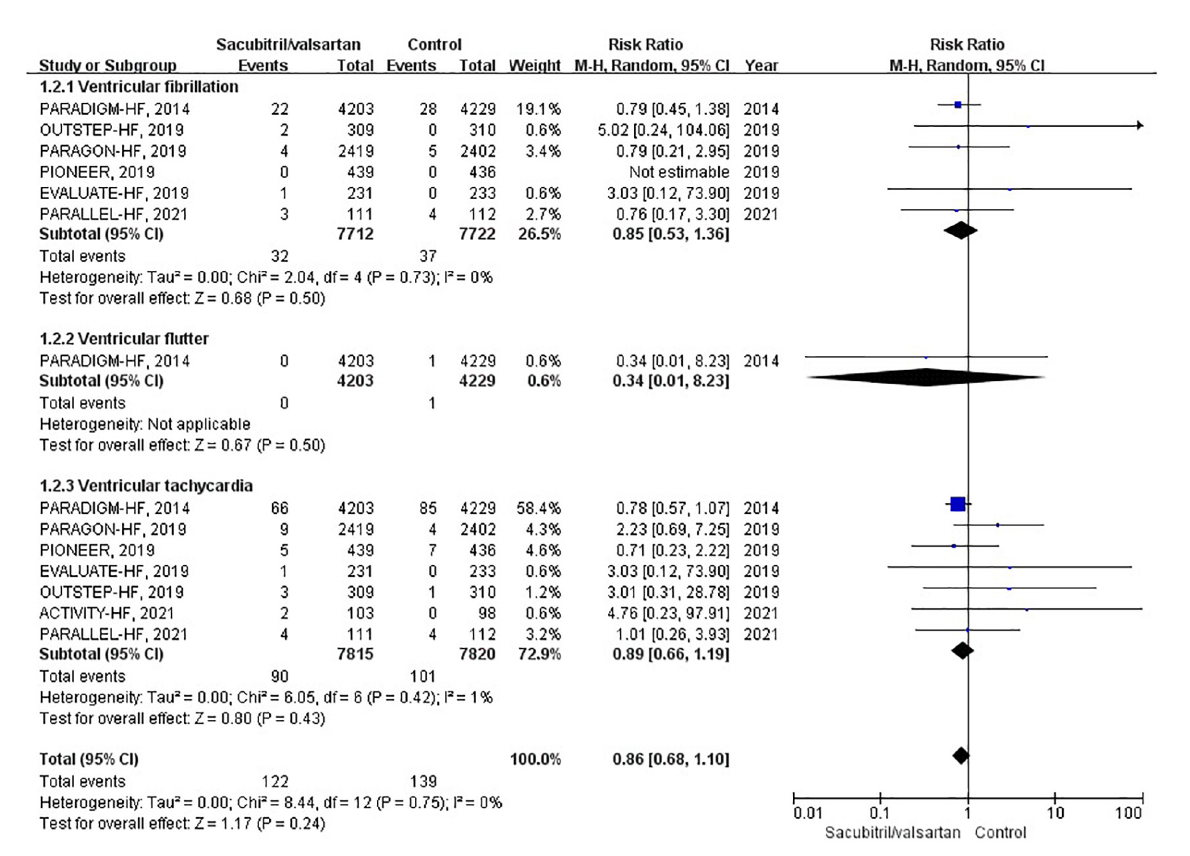
FIGURE4 Forest plot comparing the occurrence of ventricular arrhythmias between sacubitril/valsartan and